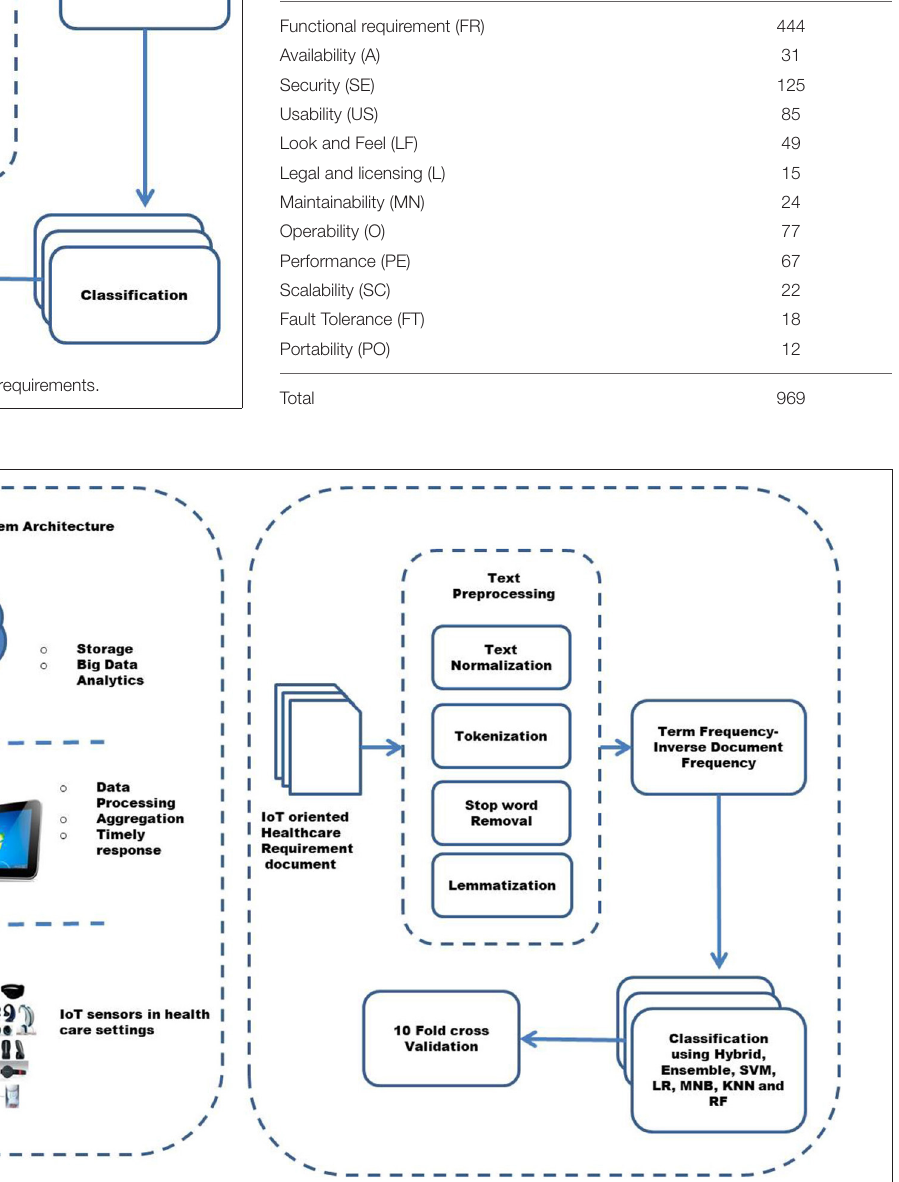
FIGURE 2 | The architectural design of Internet of Things (IoT) oriented Healthcare non-functional requirement classification.